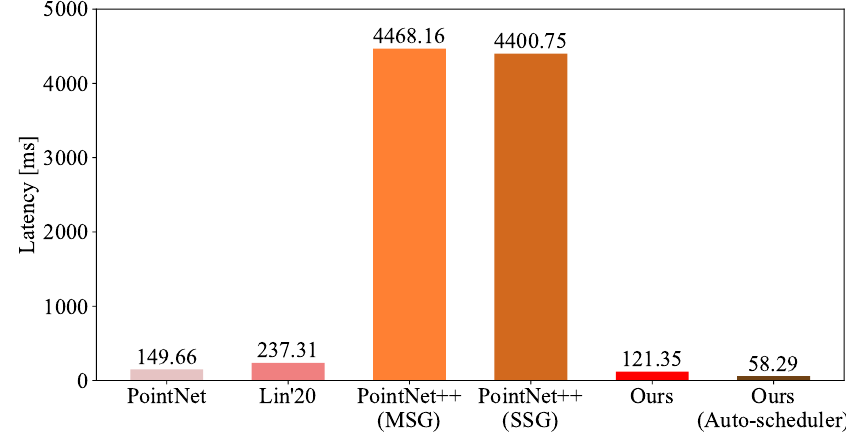
Figure 14. Comparison of the latency on the Nano CPU. Evaluating the latency on the UP Board CPU: As shown in Figure 15, we compared